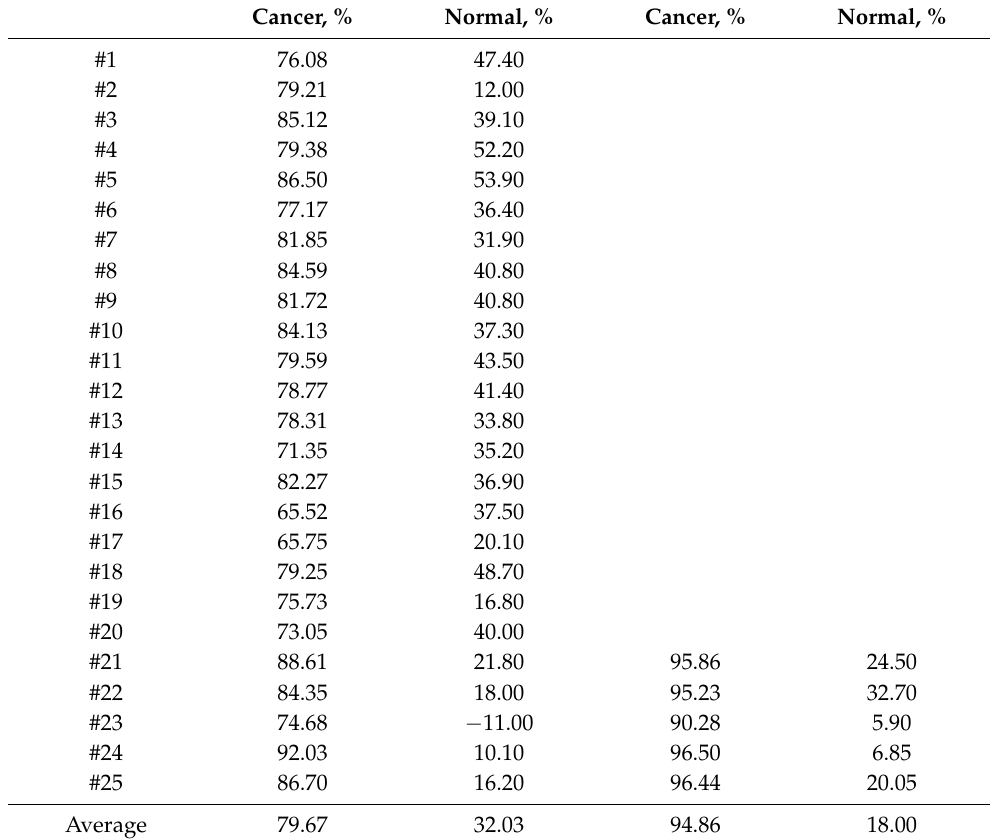
Table 1. Inhibition of cancer and normal cells by cannabis extracts at 120 h post treatment. Cancer, % Normal, % Cancer,